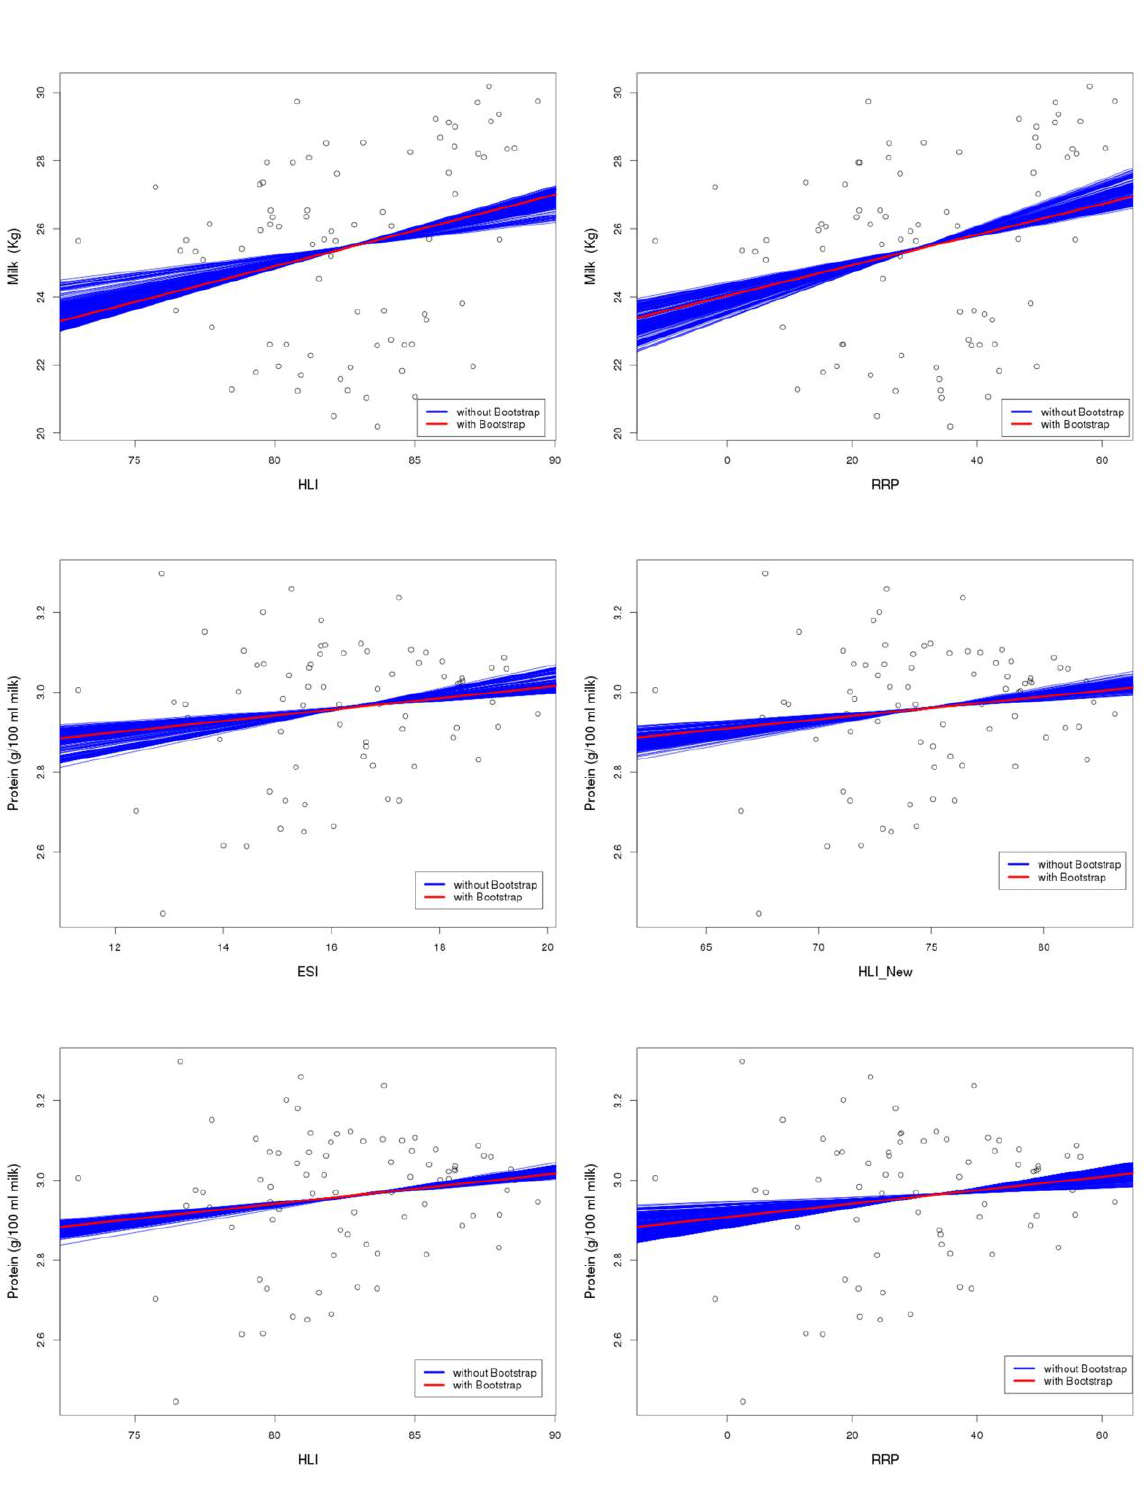
Figure A1. The best-fitted regression line before (red line) and after bootstrapping (N = 1000) (blue lines) between indices (ESI, HLI, HLI New , and RRP) and milk components (fat, protein and milk yield) in the